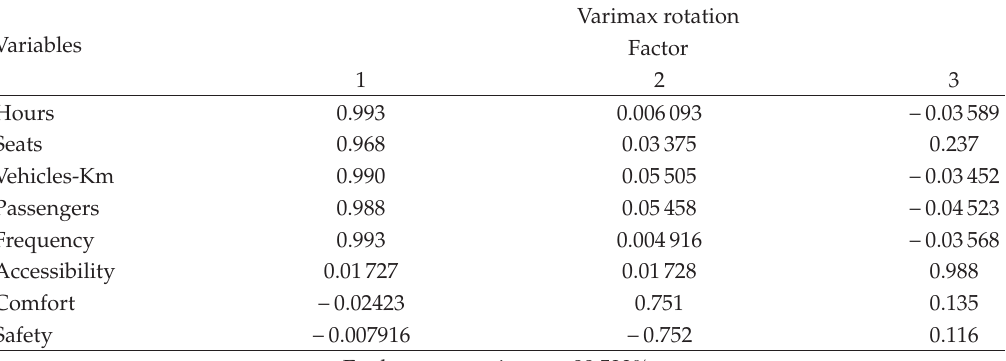
Table 3: Matrix of components.